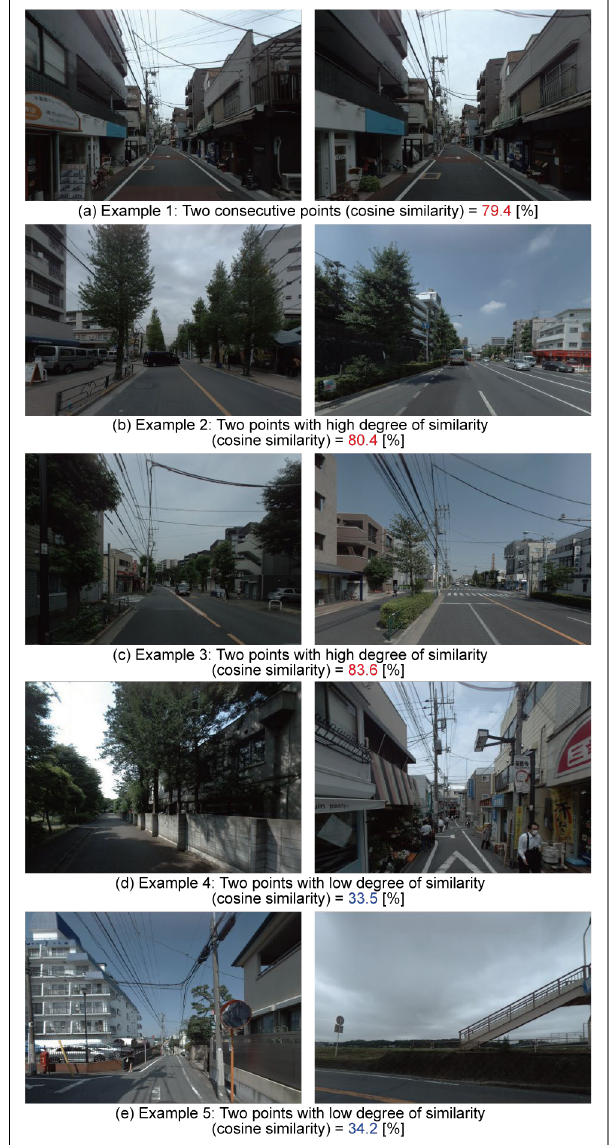
Figure 3. Examples of similar street search based on cosine